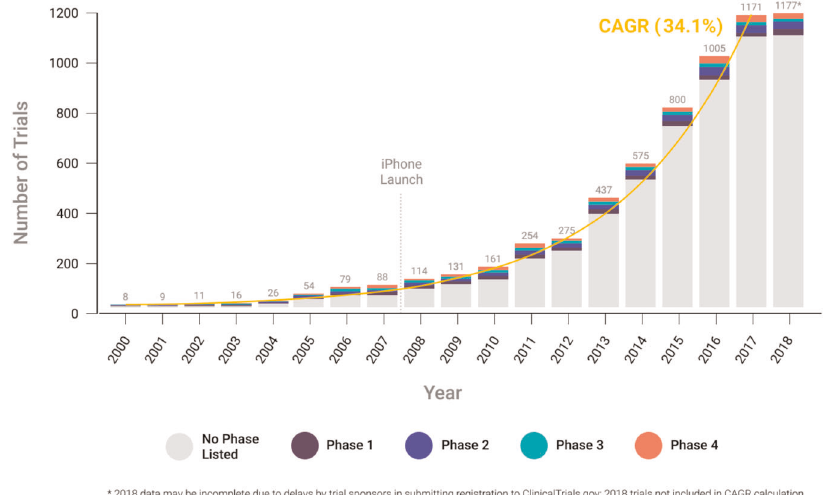
Fig. 2 Clinical trials using connected digital products by study start year and phase. Each bar represents the total number of clinical trials started annually that include a connected digital product. The trials are segmented by phase, as designated in the ClinicalTrials.gov